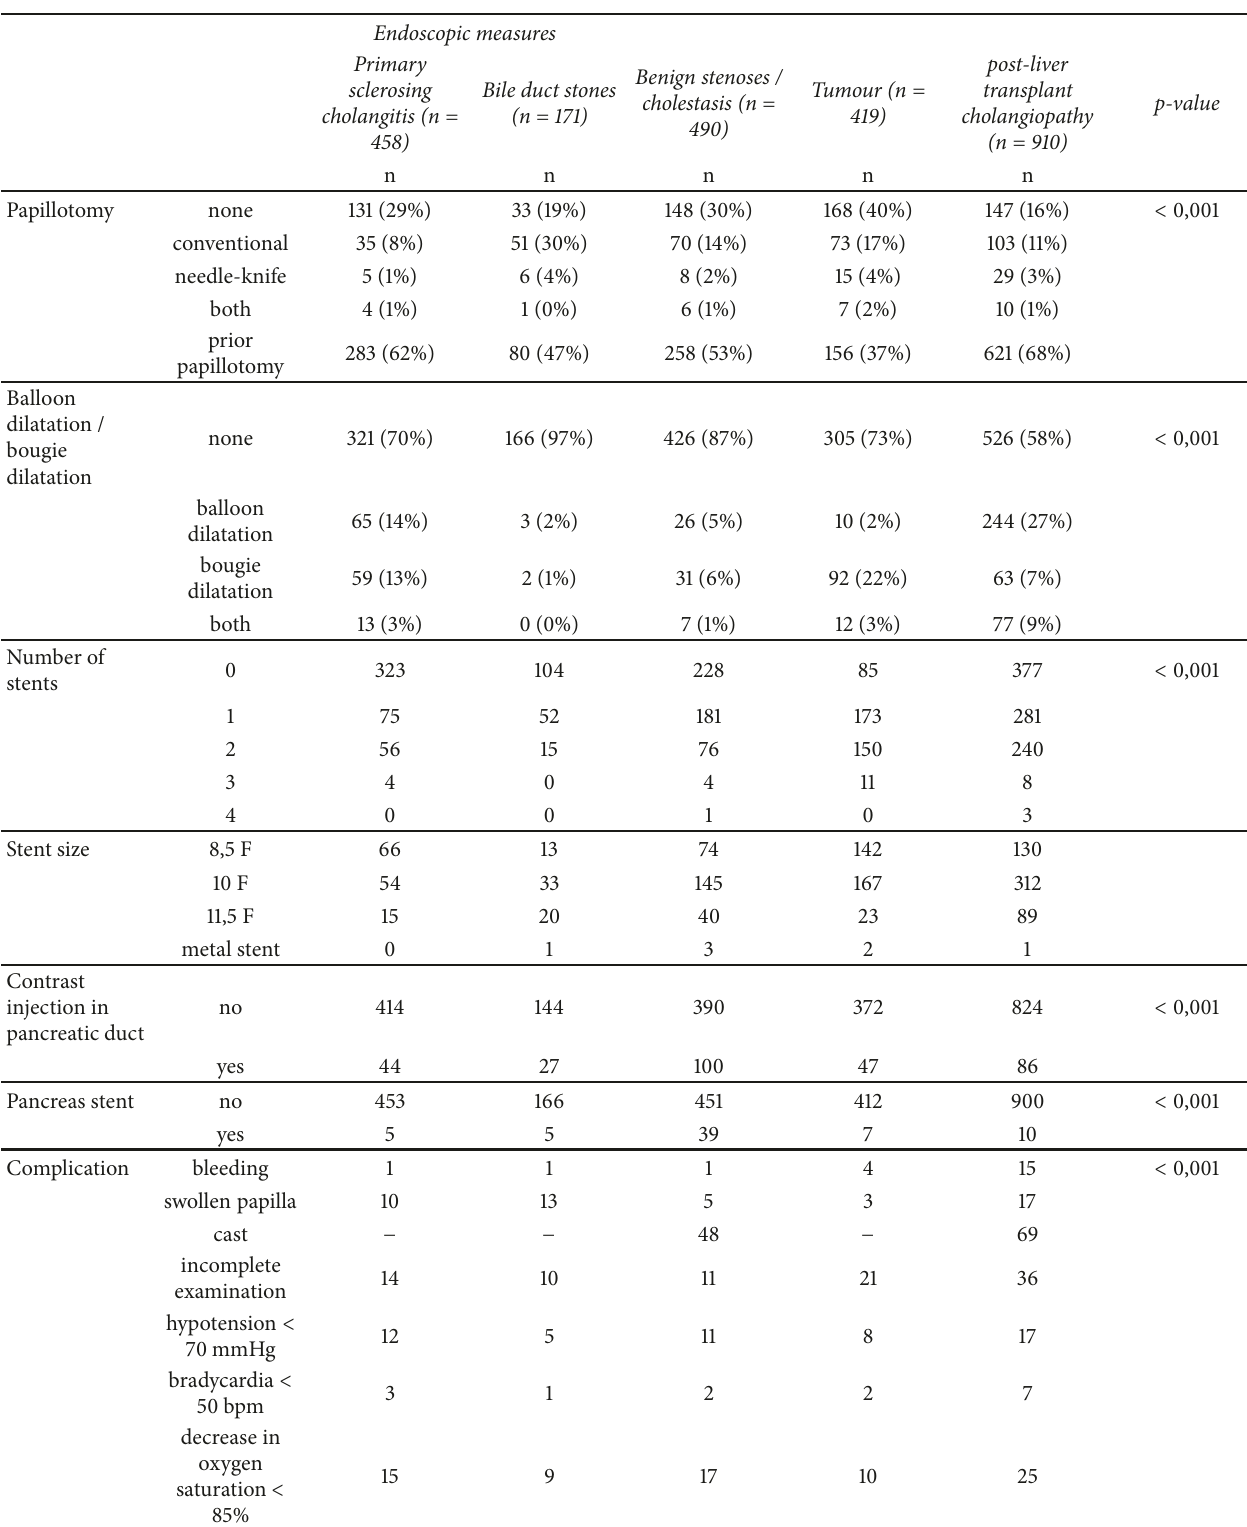
Table 2: Endoscopic interventions in the patient cohort . Patientswith primary sclerosingcholangitis (n= 458), bile ductstones(n= 171),benign stenoses/cholestasis(n= 490), malignantstenoses(n= 419), and post-livertransplant complications (n = 910) arecompared regarding distinct endoscopic